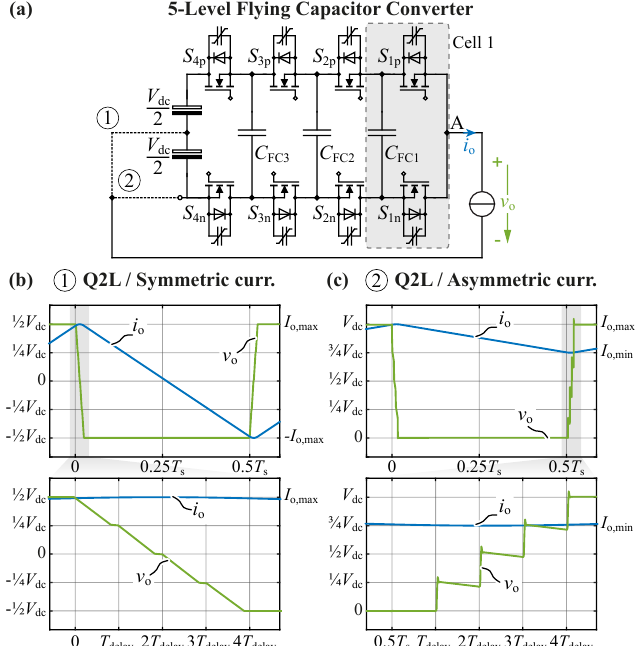
Figure 1. ( a ) Considered 5-level flying capacitor converter (5L-FCC) HB with two alternative load/DC-link connections ( 1 (cid:13) and 2 (cid:13) ). Corresponding exemplary output waveforms and char- acteristic staggered Q2L transitions of the output voltage v o for: ( b ) Symmetric output current i o (ZVS transitions), ( c ) asymmetric output current i o (ZVS & HS